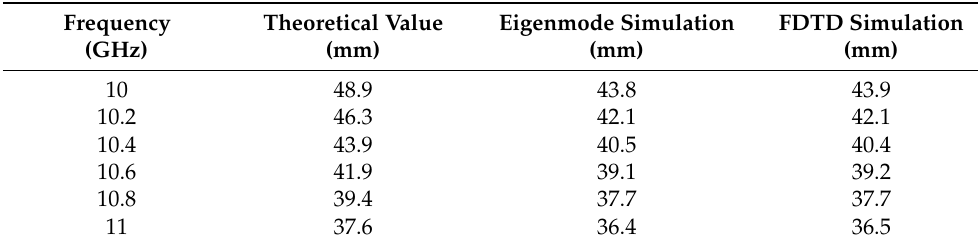
Table 3. Period lengths of the axial field distribution obtained by theoretical calculation, eigenmode simulation and FDTD simulation.